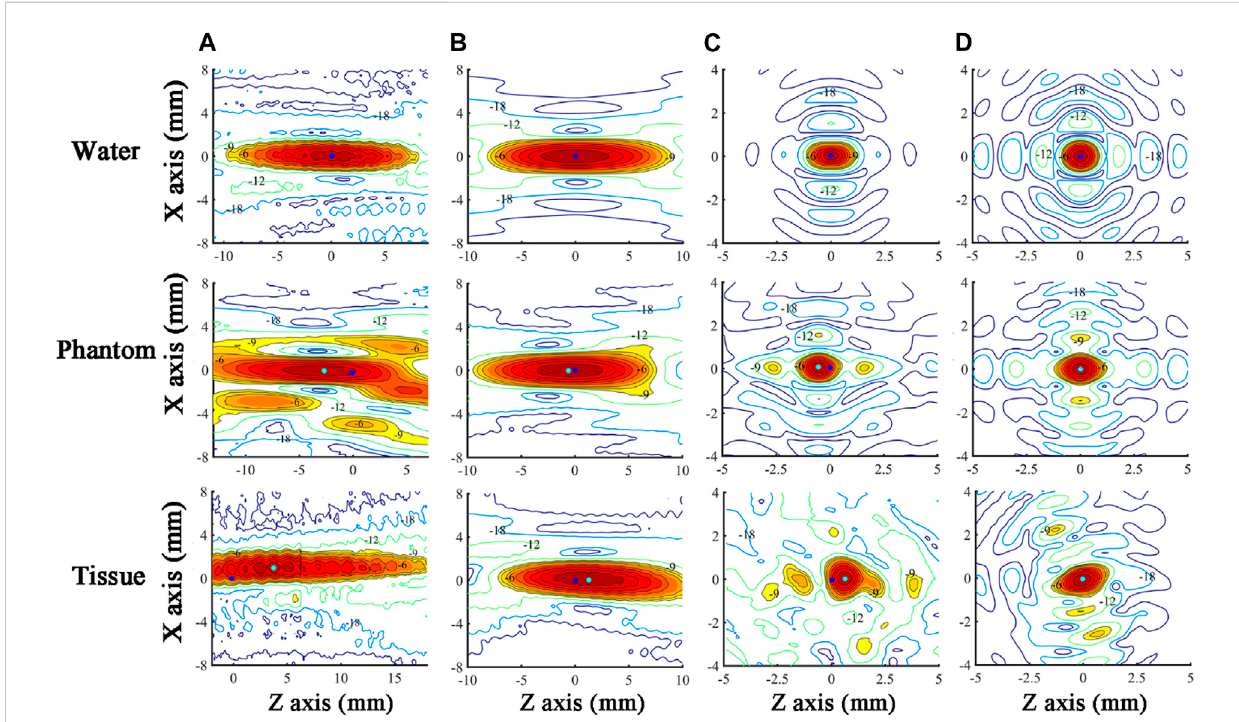
FIGURE 4 Ultrasoundbeampro fi lesintheaxial(X-Z)focalplaneofTWfocusinginthe (A) experimentand (B) simulation,andSWfocusinginthe (C) experiment and (D) simulationthroughwater,Phantom,andTissue.Theacousticfocusandtheoriginofscanningcoordinates(acousticfocusinwater)aremarkedas cyan and blue dots, respectively. The regions with a normalized pressure larger than − 9 dB are in